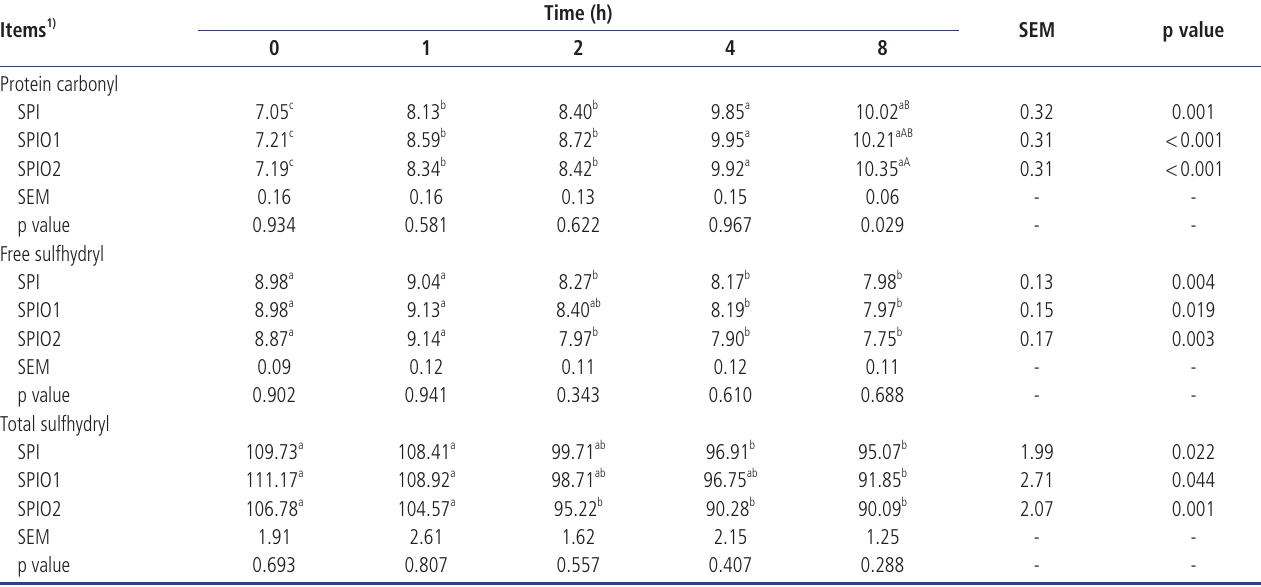
Table 2. Protein carbonyl, free and total sulfhydryl group content of SPI heated with different soybean oil contents at 100°C (nmol/mg protein) Items 1)